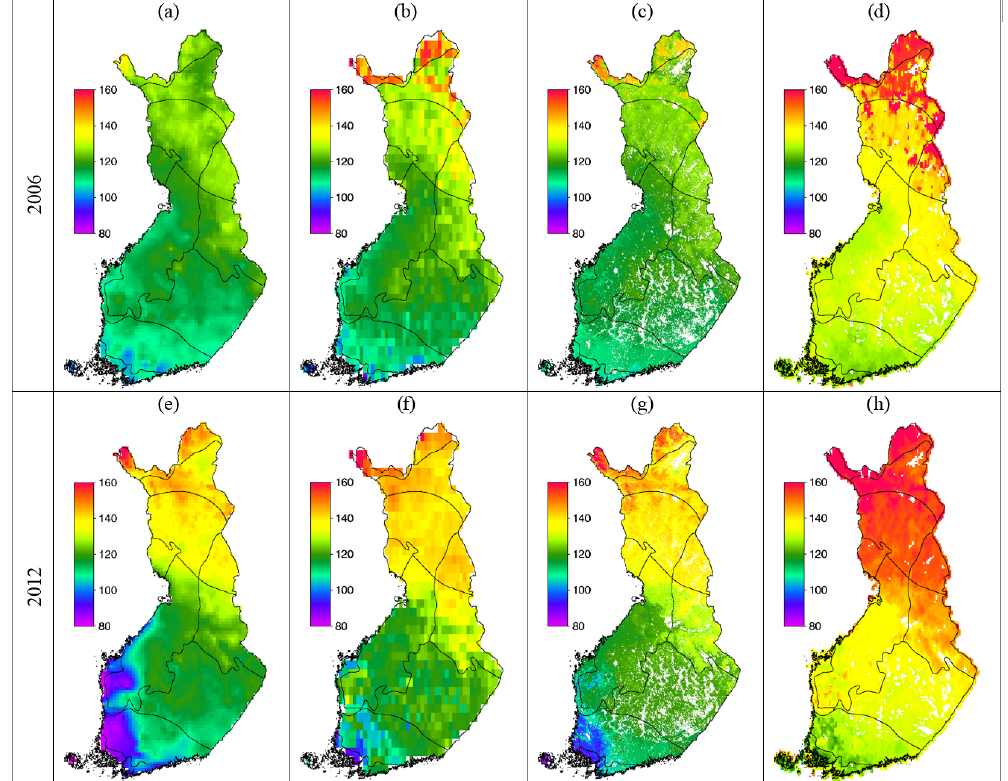
Figure 7. The progress of spring in 2006 and 2012 starting from (a, e) the melt-off day of the permanent snow cover in Finland based on in situ snow depth measurements (Solantie et al., 1996; Kersalo and Pirinen, 2009), (b, f) the surface albedo reaching the 20% threshold value of its dynamic range during the melting season (Anttila et al., 2016a; Karlsson et al., 2017), (c, g) the complete disappearance of the snow cover based on the FSC product (Metsämäki et al., 2018) and (d, h) the greening-up day based on MODIS NDWI (Böttcher et al.,